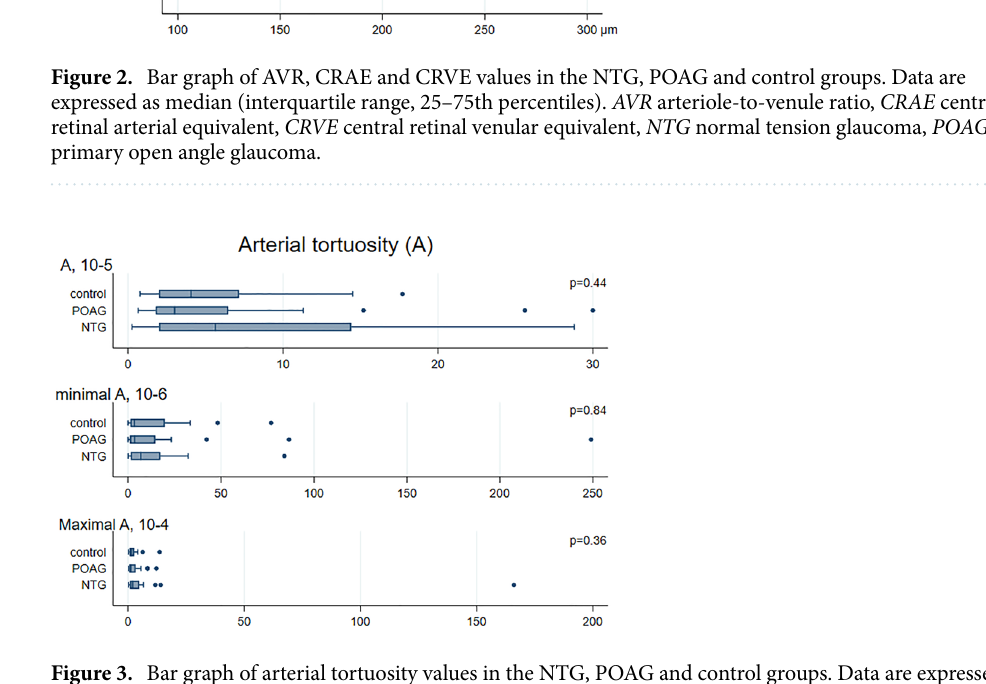
Figure 3. Bar graph of arterial tortuosity values in the NTG, POAG and control groups. Data are expressed as median (interquartile range, 25–75th percentiles). NTG normal tension glaucoma, POAG primary open angle glaucoma.